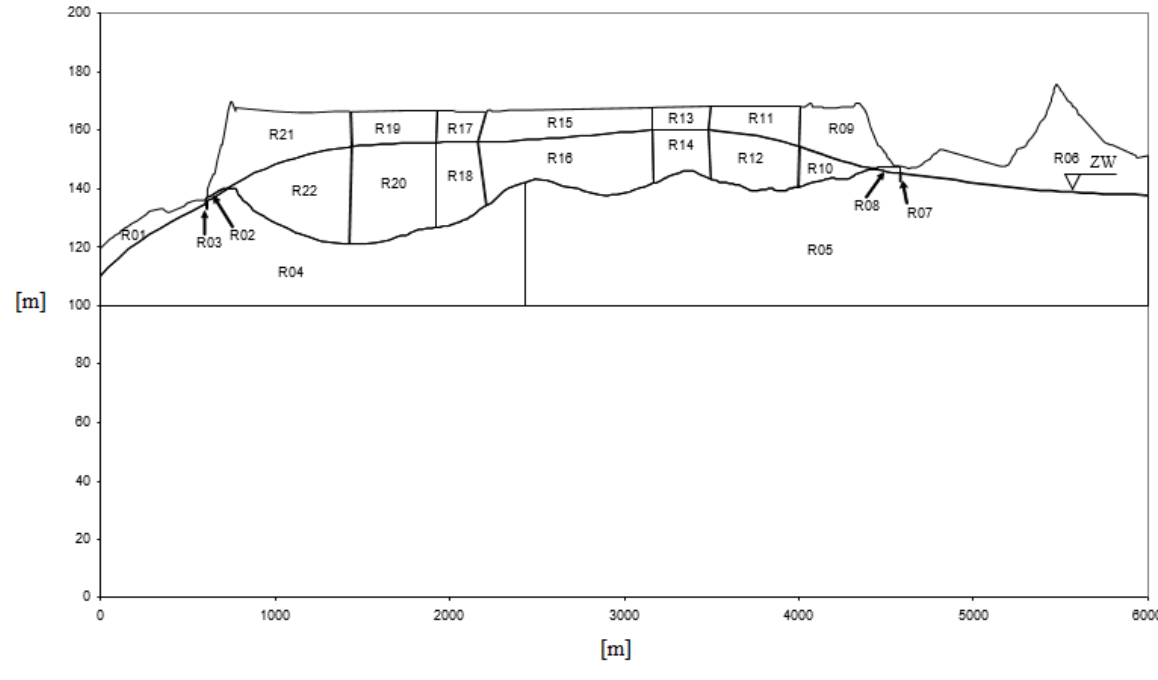
Figure 3: Division of the 2D computational domain into regions (Bartlewska